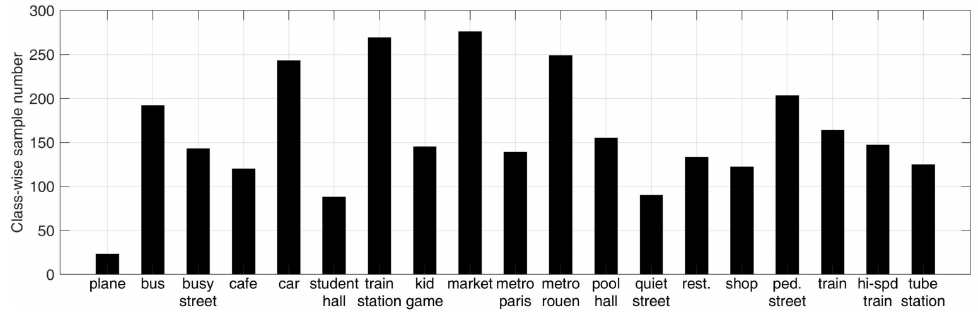
Figure 7. Statistics of acoustic scene recordings collection by categories in Rouen dataset.